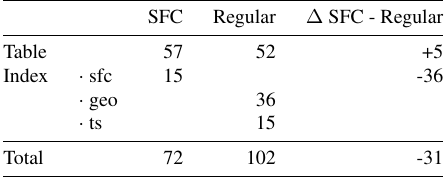
Figure 4. Query results using the SFC approach.